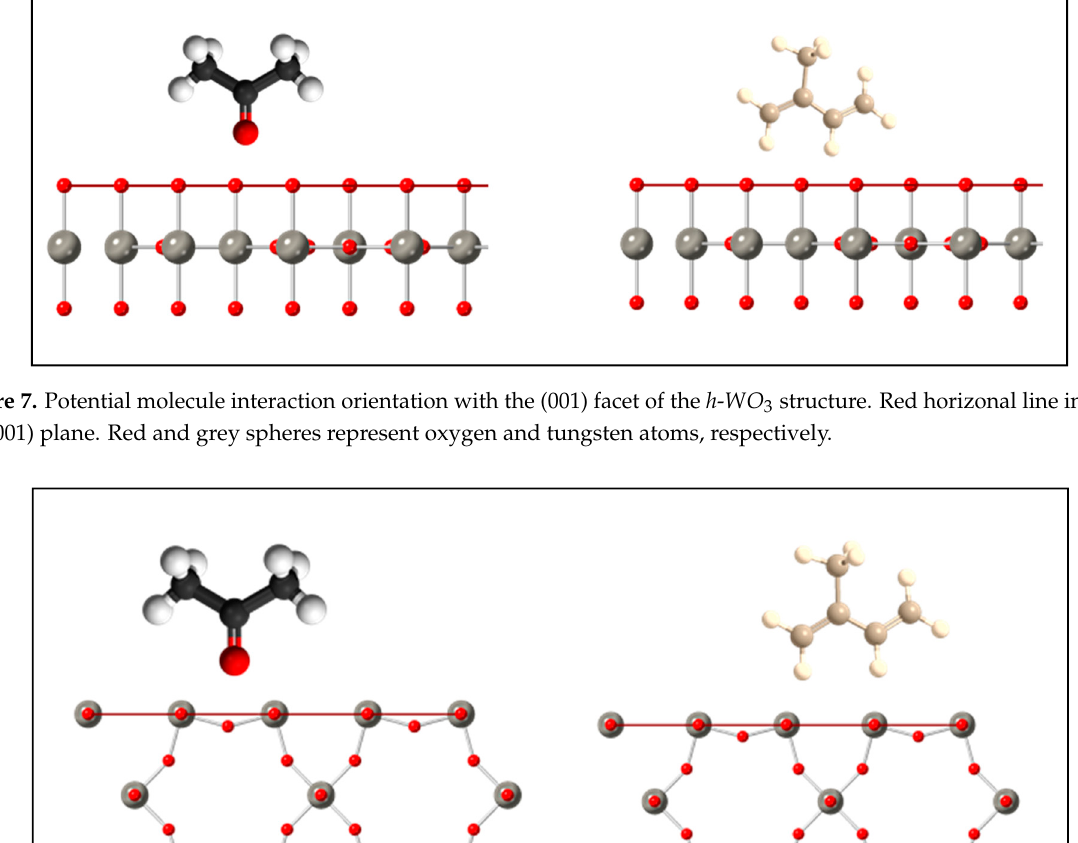
Figure 6. Geometrical structures of the (001) terminated surface ( a ) and the (100) terminated surface ( b ) from h- WO3. The crystal structure is ICSD 32001 from Gerand et al. Ref [3]. Red spheres indicate oxygen atoms, while green spheres indicate tungsten atoms. The viewing directions for the structures from left to right are [010], [111], [001], and [101].